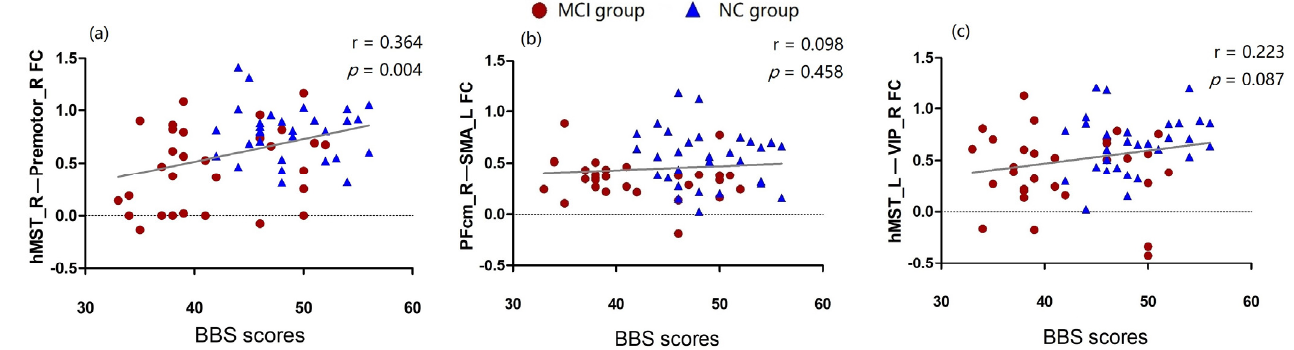
Figure 2. The linear correlation between the functional connection and the BBS scores. ( a ) correlation analysis of hMST_R–premotor_R functional connectivity and the BBS score(r = 0.364, p = 0.004); ( b ) correlation analysis of PFcm_R–SMA_L functional connectivity and the BBS score(r = 0.098, p = 0.458); ( c ) correlation analysis of hMST_L–VIP_R functional connectivity and the BBS score(r = 0.223, p = 0.087).